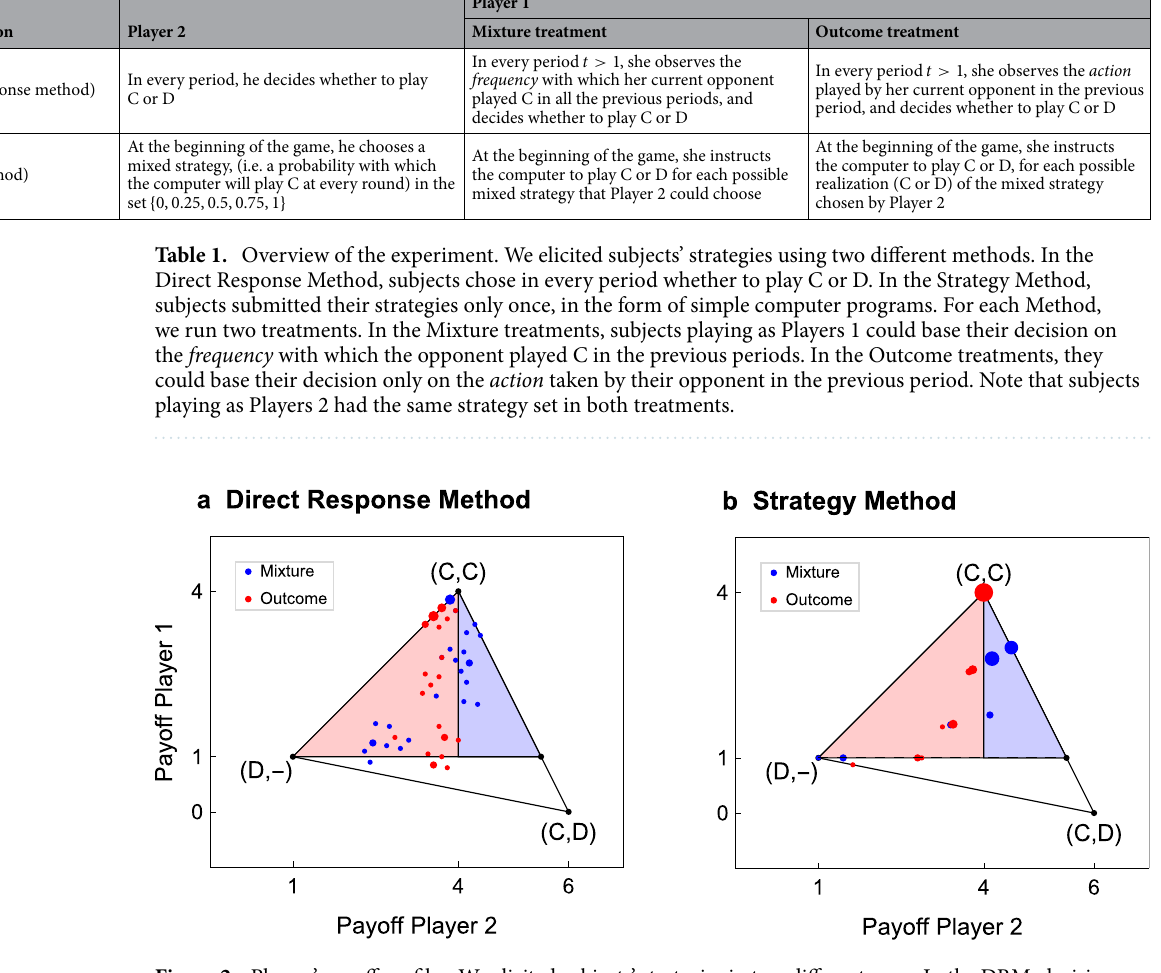
Figure 2. Players’ payoff profiles. We elicited subjects’ strategies in two different ways. In the DRM, decisions were made at each round of the repeated game ( a ). In the SM, subjects submitted their strategies in the form of simple computer programs ( b ). Note that, since in the SM players 2 could choose among a predetermined set of strategies (see Table 1) data points are less dispersed in this case. The coordinates of each dot are the average payoff of a single Player 2 (x-axes) and the average payoff that Players 1 obtained when they interacted with him (y-axes). Dots are red when Player 1 can observe only the action that was chosen by Player 2 in the previous round (i.e., Outcome treatment, n = 27 ); they are blue when Player 1 observed the frequency with which Player 2 chose the different actions in all the previous rounds (i.e., mixture treatment, n = 29 ). Dots’ size is proportional to the number of occurrences of that data point. Our theory predicts that all red dots should be in the red area, while blue dots may appear in the blue area. The results from our experiment are broadly in agreement with these